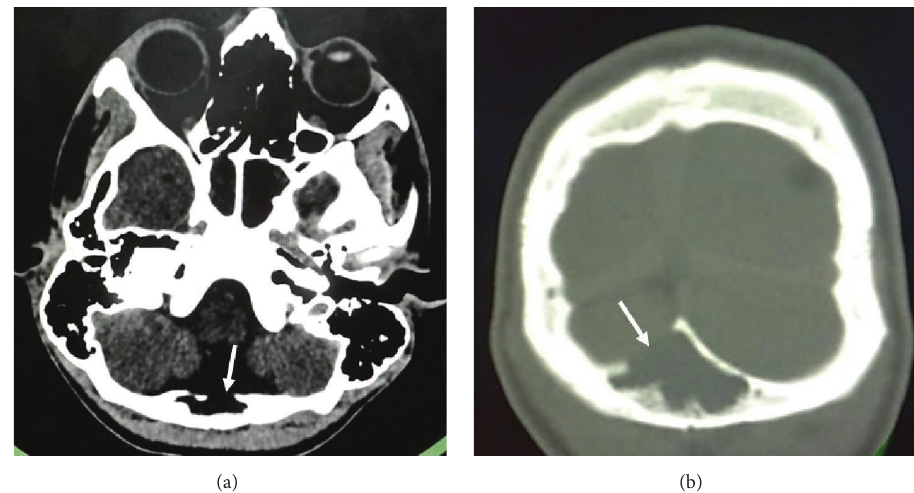
Figure 2: Axial MDCT 5 years later: (a) soft tissue window and (b) bone window showing CSF density lesion in the diploic space of the occipital bone with a break in the continuity of the inner table and expansion of the diploic space (arrows).